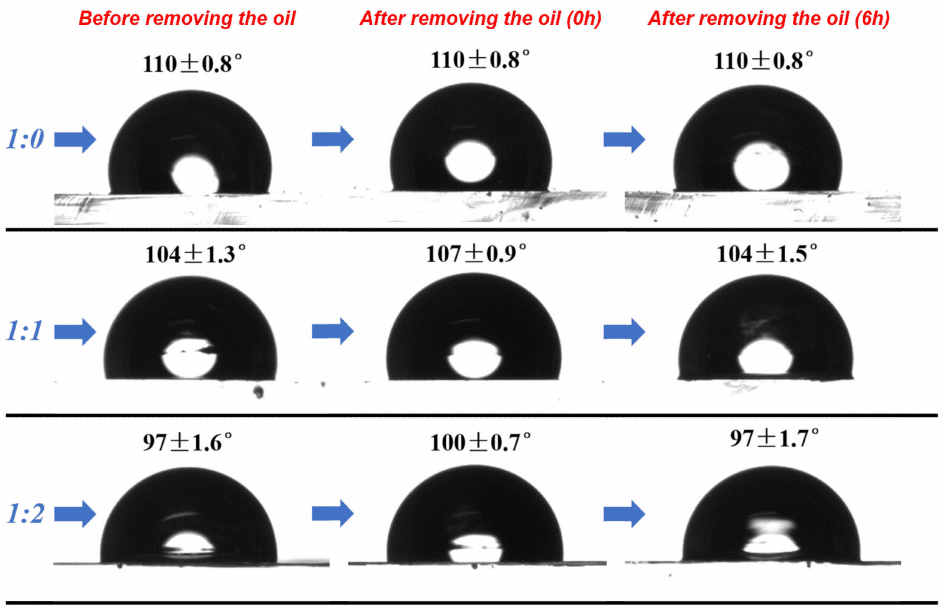
Figure 5. Water contact angles before and after removing the oil from di ff erent sample surfaces.